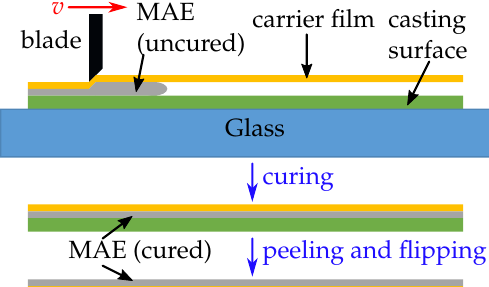
Figure 2. “Upside-down” fabrication method for an MAE film on a plastic carrier